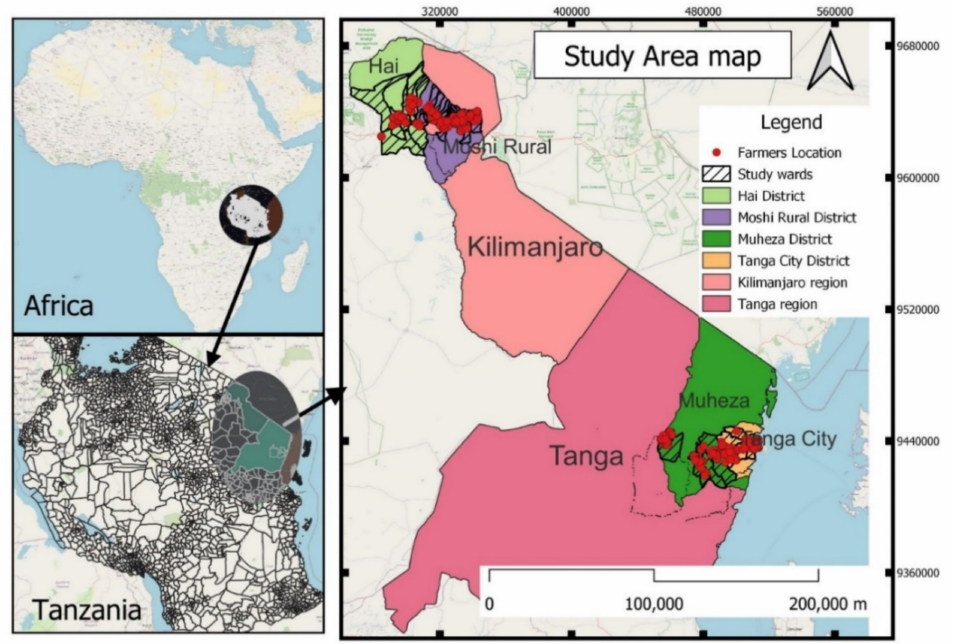
Figure 1. Study area map showing low- and high-stress dairy production environments from the two milksheds in